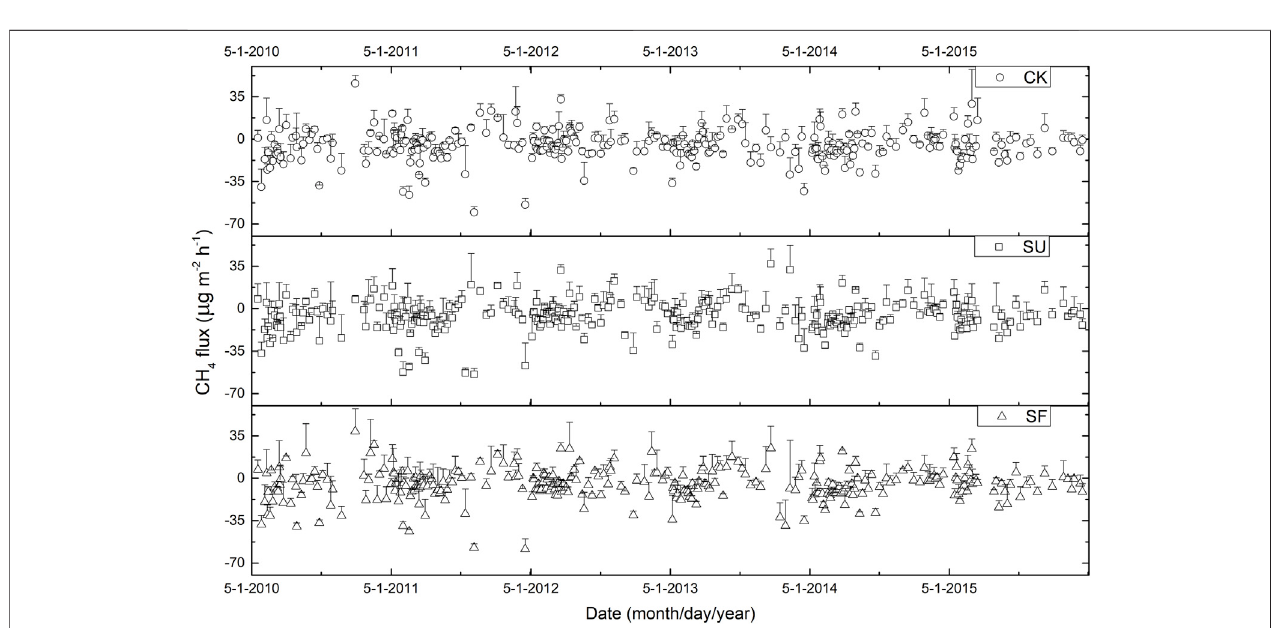
FIGURE 5 | Seasonal dynamics of CH 4 fl uxes in the CK, SU, and SF treatments from May 2010 to April 2016. The bars represent the standard deviations of the means ( n (cid:2) 3).